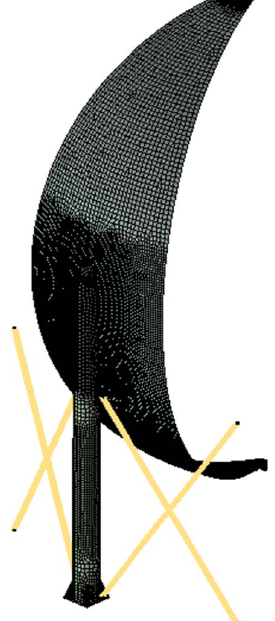
Figure 10. Discrete model—the general view.